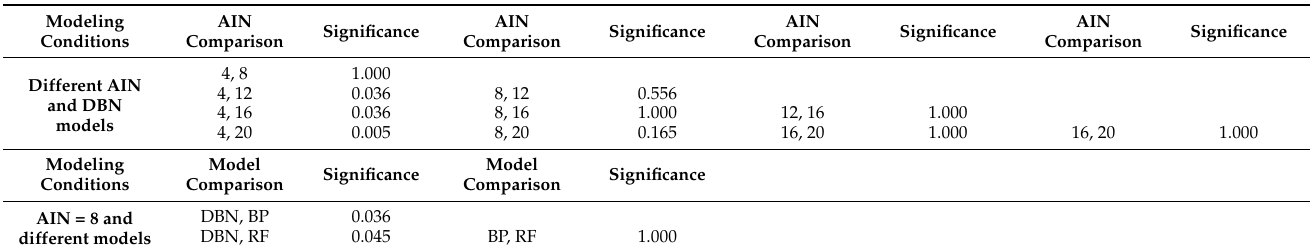
Table 7. Friedman two-way ANOVA tests by rank for different AIN values and different